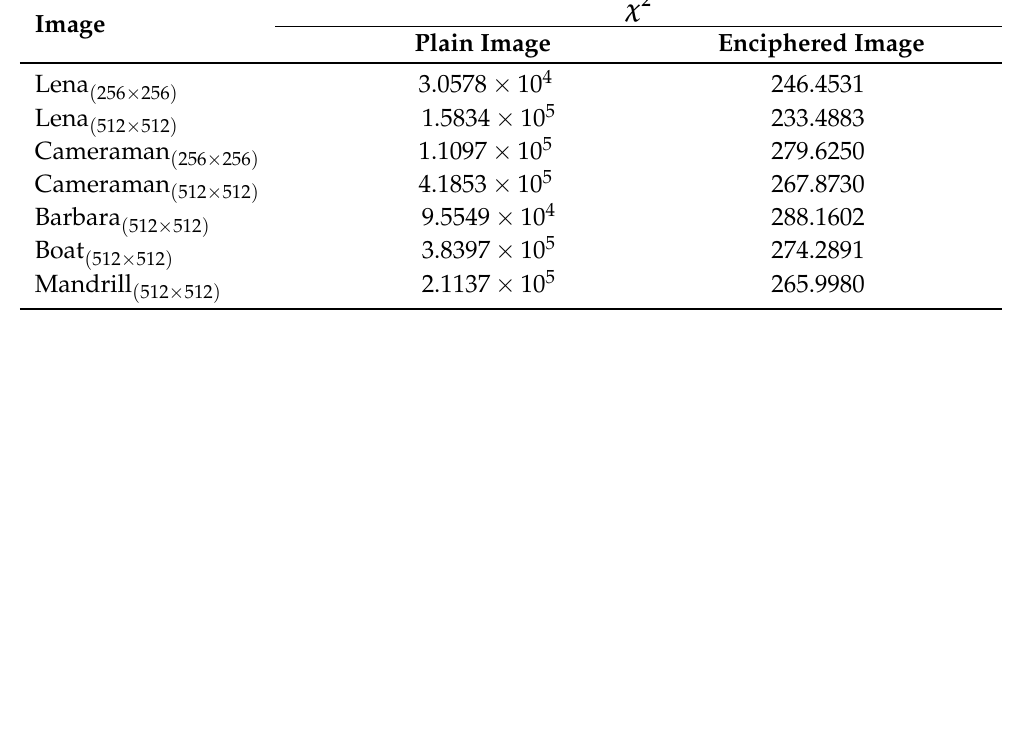
Table 2. χ 2 values of plain and enciphered images at c 0 = 1, c 1 =